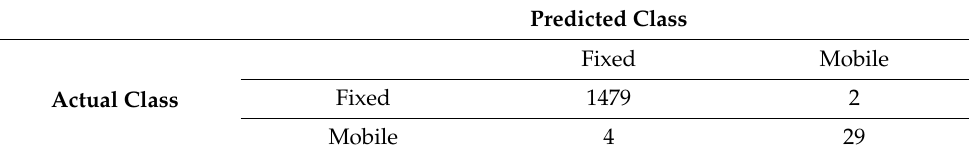
Figure 3. Example of 3D plot of the most relevant features. Table 5. Confusion matrix.